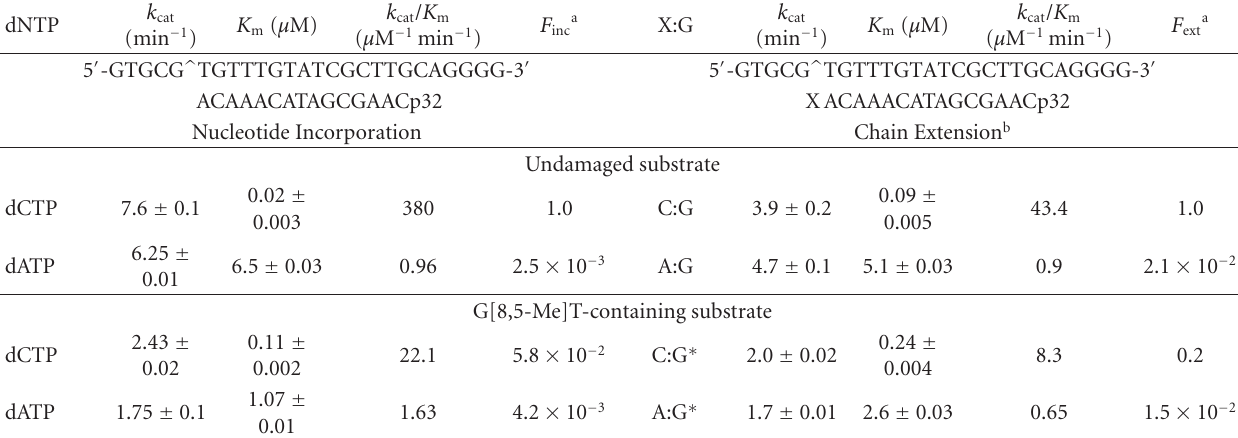
Table 1: Kinetic parameters for dCTP and dATP incorporation and chain extension by human DNA polymerase η (6.4nM) on an undamaged and G[8,5-Me]T cross-link containing substrate.